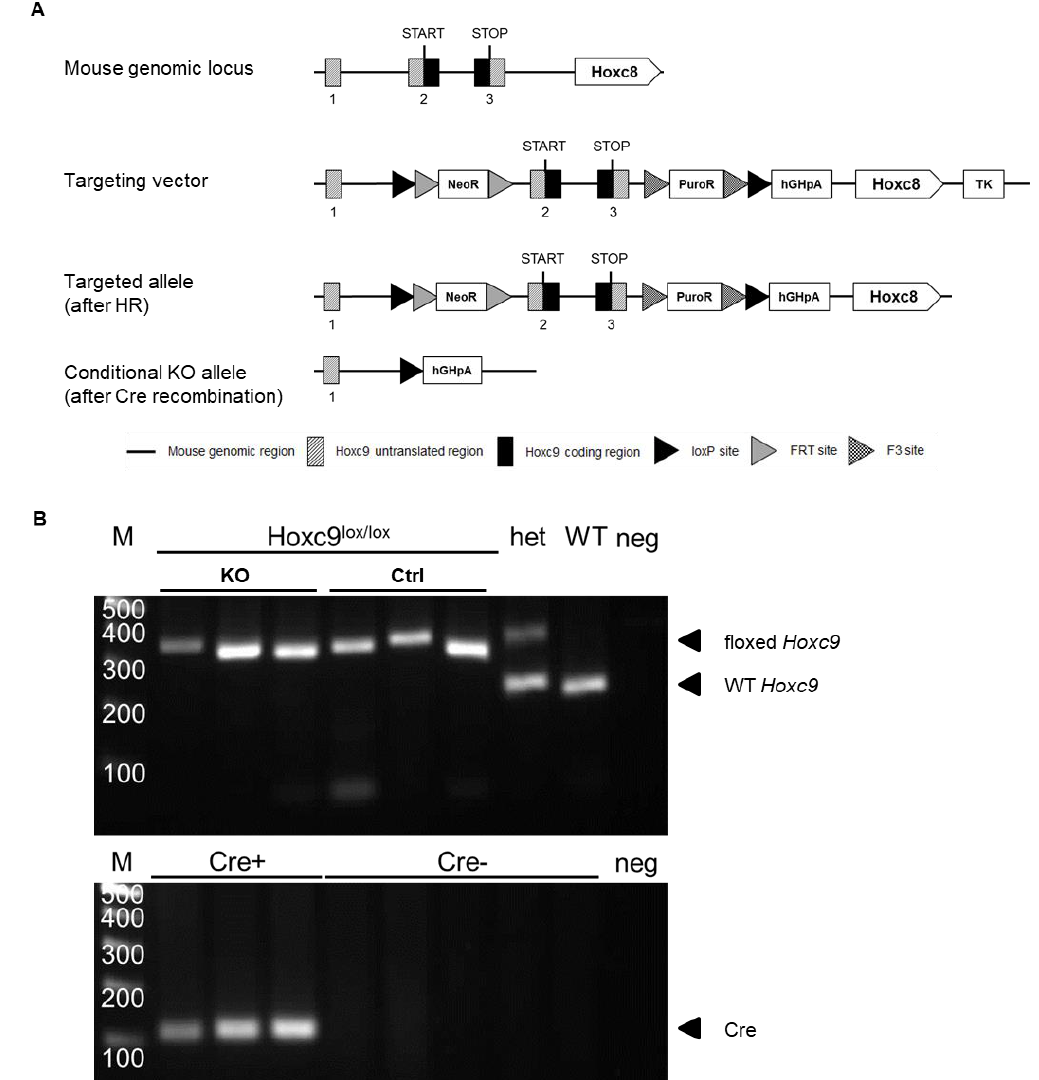
Figure 1. Targeting strategy for the generation of AT Hoxc9 - / - mice. ( A ) Schematic representation of the genomic Hoxc9 locus with the neighboring Hoxc8 locus, the targeting vector, and the loxP-flanked Hoxc9 allele after homologous recombination (HR) before and after crossing with transgenic mice expressing Cre recombinase under the control of the Fabp4 promotor. The targeting vector consists of a 5.3 kb loxP-flanked region containing Hoxc9 exons 2 and 3, a thymidine kinase cassette (TK) as a negative selection marker, and two positive selection markers: a neomycin resistance cassette (NeoR) flanked by FRT sites and a puromycin resistance cassette (PuroR) flanked by F3 sites. The knockout allele (KO) is characterized by loss of Hoxc9′ s coding region located in exons 2 and 3. ( B ) Agarose gel electrophoresis after PCR of genomic DNA from homozygous floxed Hoxc9 ( Hoxc9 lox/lox , predicted PCR product of 324 bp), wild-type (WT, Hoxc9 wt/wt , predicted PCR product of 205 bp), heterozygous Hoxc9 ( Hoxc9 lox/wt , predicted PCR products of 205 and 324 bp), and Fabp4- Cre + mice (Cre + , predicted product of 100 bp). Negative control lane without genomic DNA (neg). Arrows indicate PCR products.